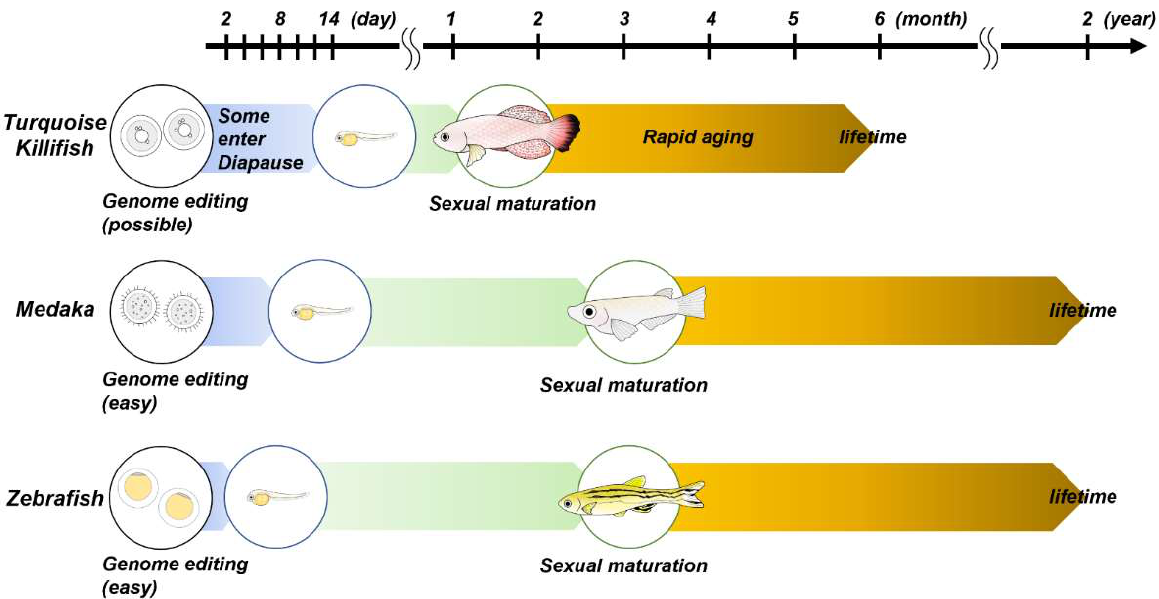
Figure 1. This schema shows the life cycles of zebrafish, medaka and turquoise killifish. For further details, please refer to the main text.